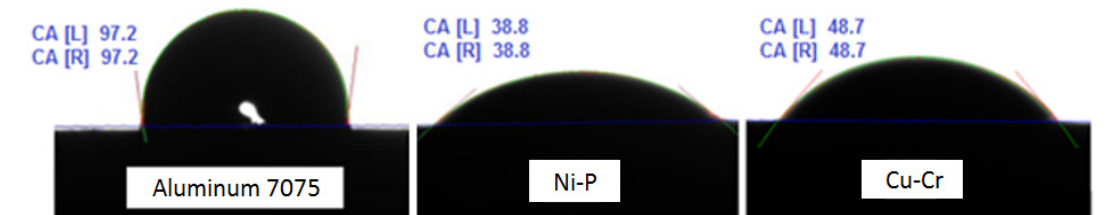
Figure 3. Wettability of the substrate and the coatings with distilled water.